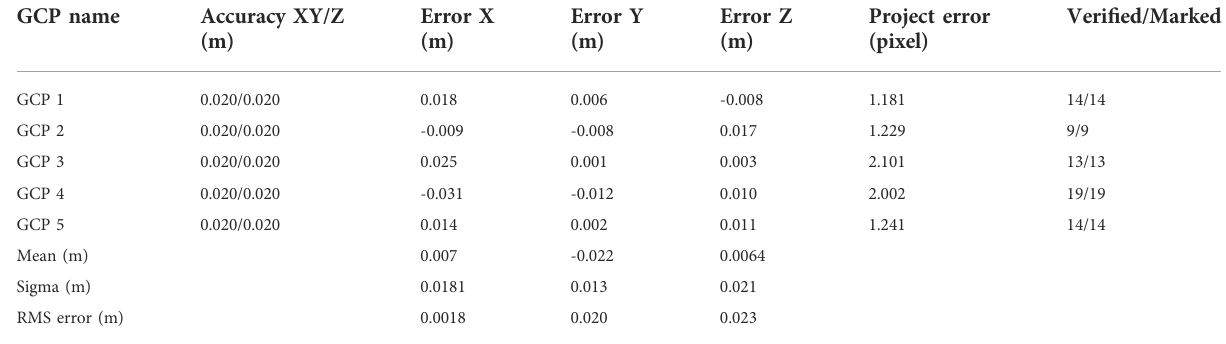
TABLE 7 Ground control points accuracy.